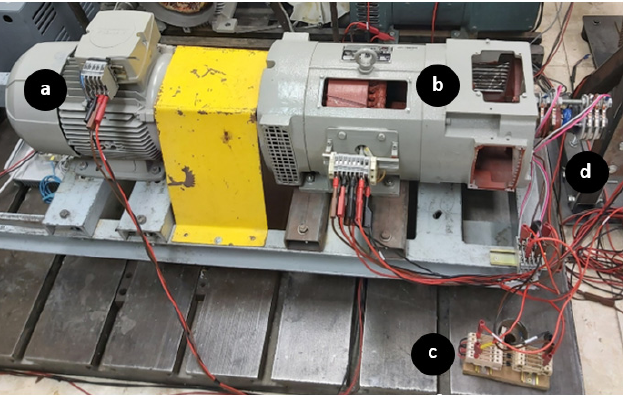
Figure 12. BSM schematic representation. On top, of the regular arrangement, and on the bottom, the experimental setup ((1) Exciter; (2) bridge rectifier; (3) main machine). Rotating elements are contained in gray sections.